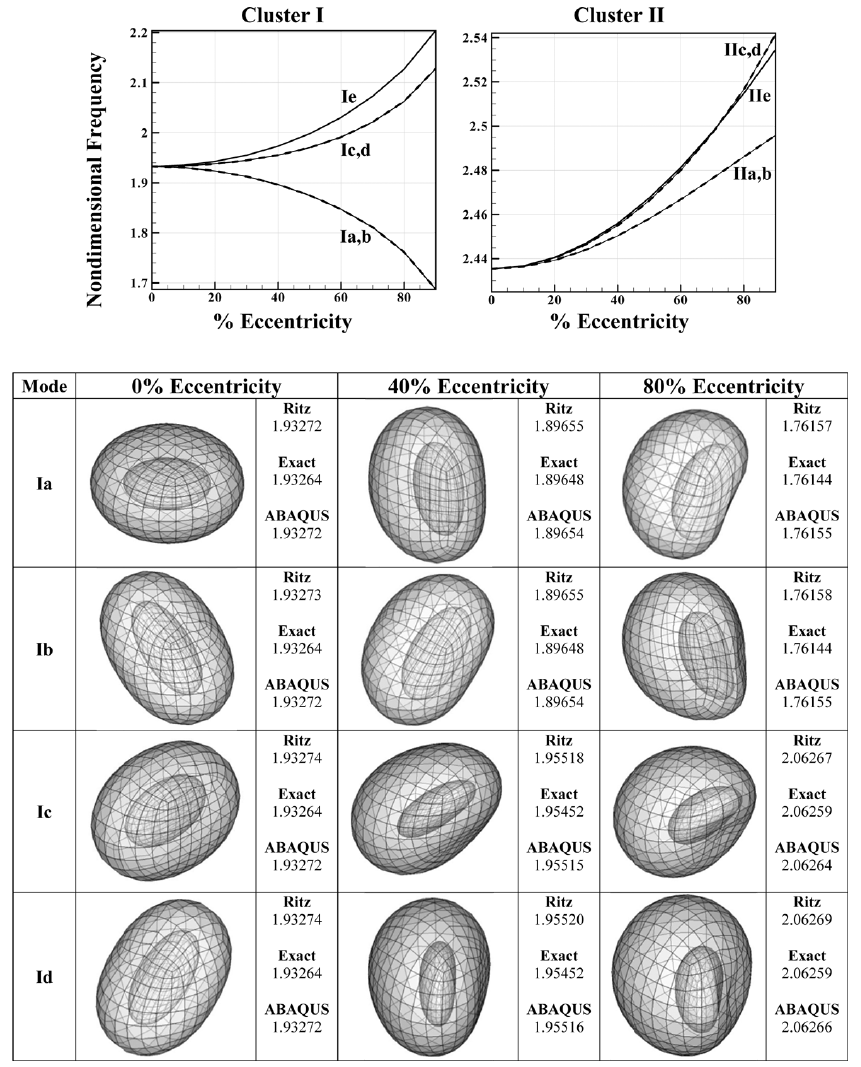
Fig. 6. Variation of the fi rst two frequency clusters with eccentricity parameter for the solid sphere with an internal spherical cavity, along with the fi rst four three-dimensional mode shapes for selected eccentricity